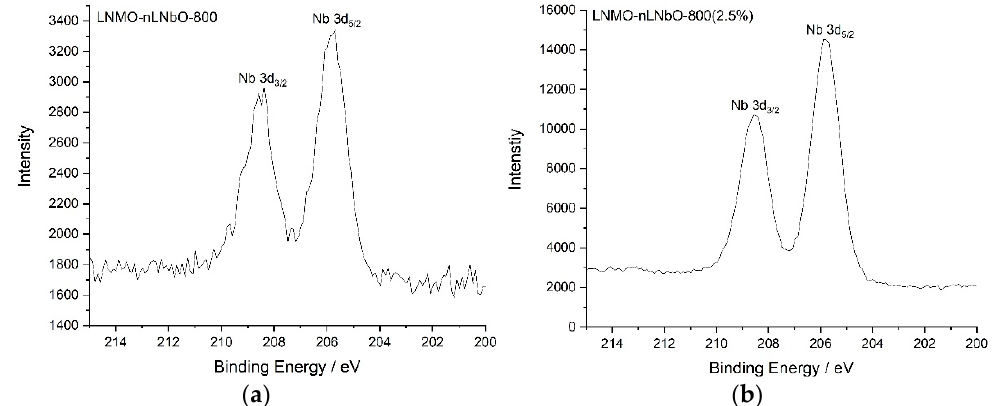
Figure 3. Nb 3d 3/2 and Nb 3d 5/2 XPS spectra of ( a ) LNMO-nLNbO-800 and ( b ) LNMO-nLNbO-800 (2.5%).